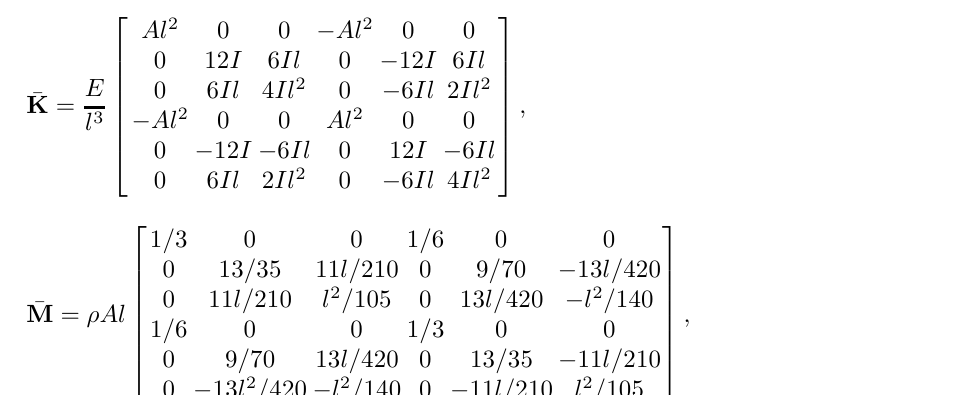
Fig. 2. Finite element in global coordinates